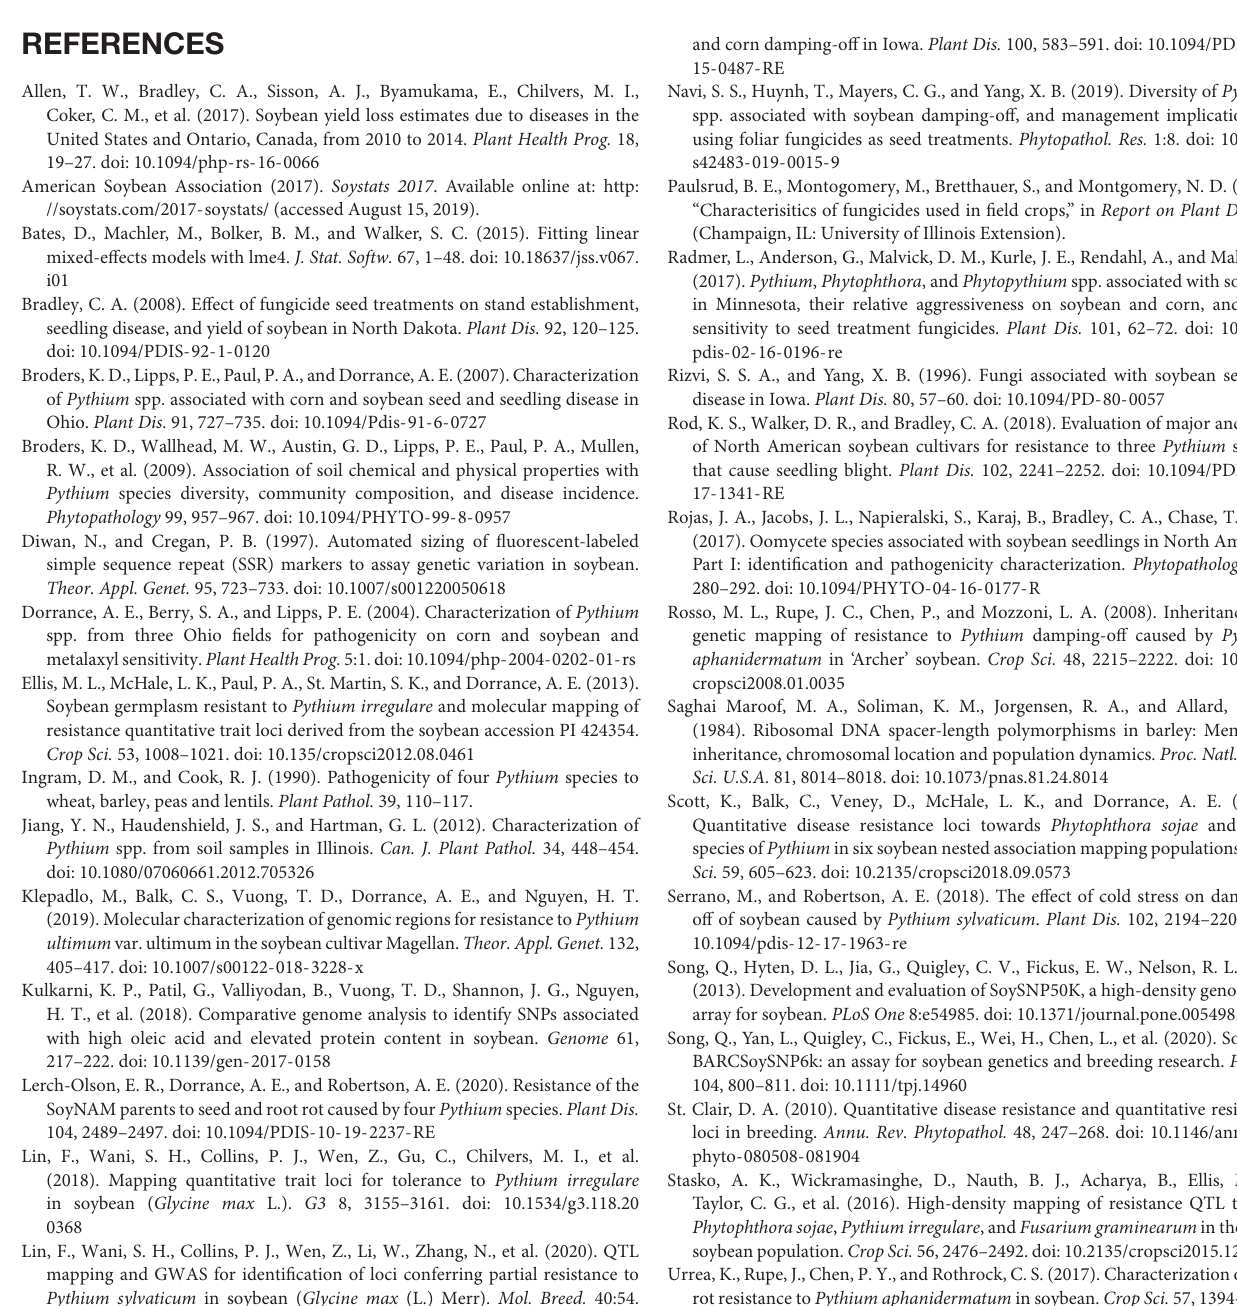
Supplementary Figure 8 | A large effect QDRL on chromosome 6 in POP4 detected by both disease reaction traits of seed rot severity (SRS) and the percent of rotted seeds in inoculated plates (ROTS) by Pythium sylvaticum . The two traits had CIM LOD scores of 12.5 and 12.1, respectively. The closest QDRL marker to this large effect QDRL is Gm06_31863080_C_T. Supplementary Figure 9 | A large effect QDRL identified in POP4 on chromosome 6 by two disease reaction traits of seed rot severity (SRS) and the percent of rotted seeds in inoculated plates (ROTS) by Pythium irregulare . This